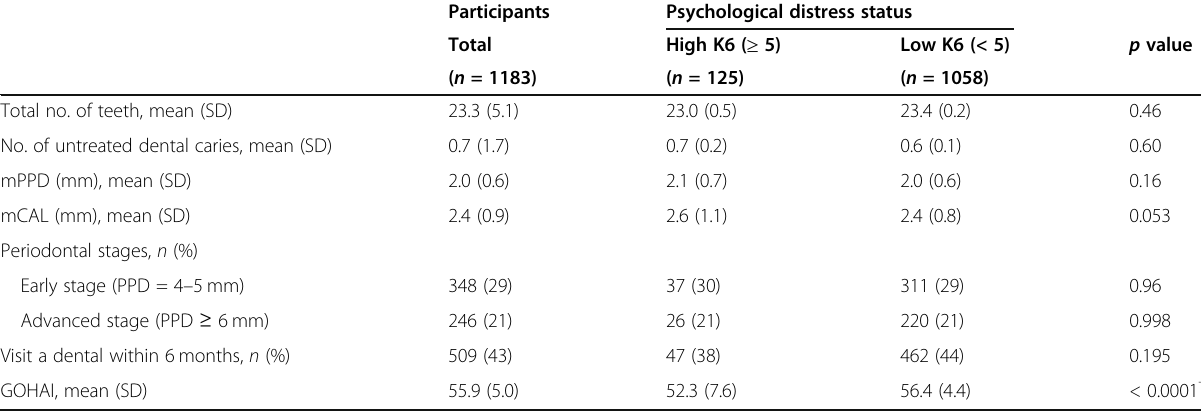
Table 2 Comparisons of oral health status between the K6 high group and the K6 low